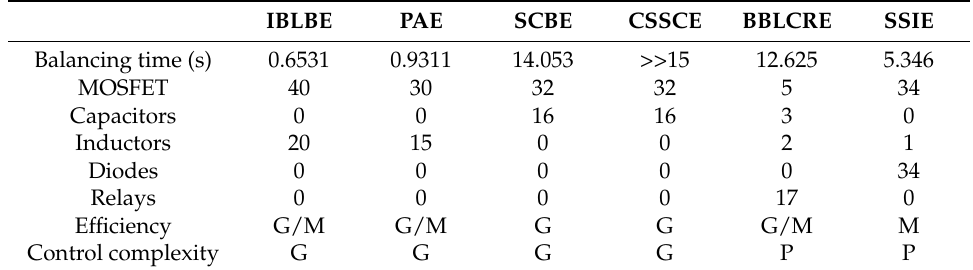
Table 4. Comparison of different equalizers with 16 cells (Balancing time: the time when the